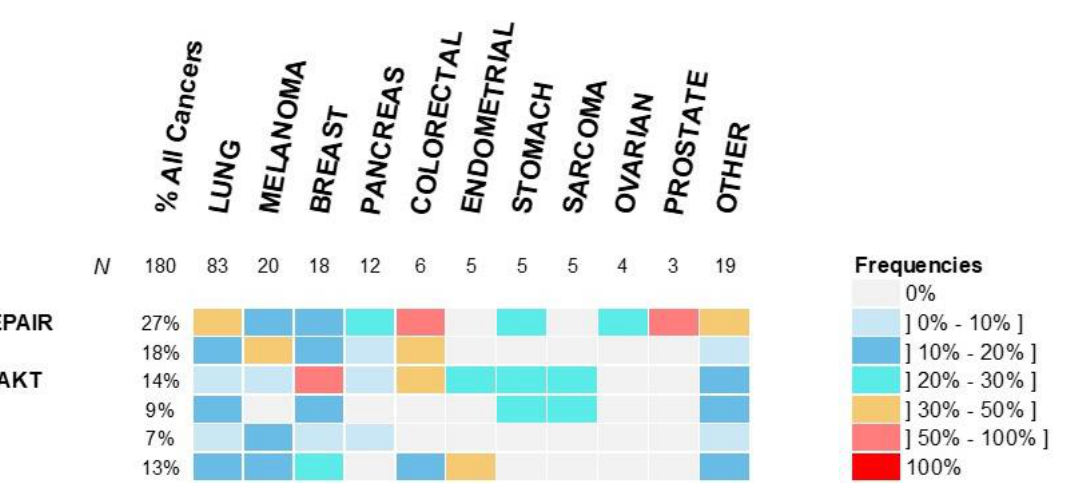
Figure 3. Incidence of molecular alterations according to molecular pathways and tumor type. Percentage of patients with an alteration of a molecular pathway per cancer type is color-coded as indicated on the labels on the right of the graph.